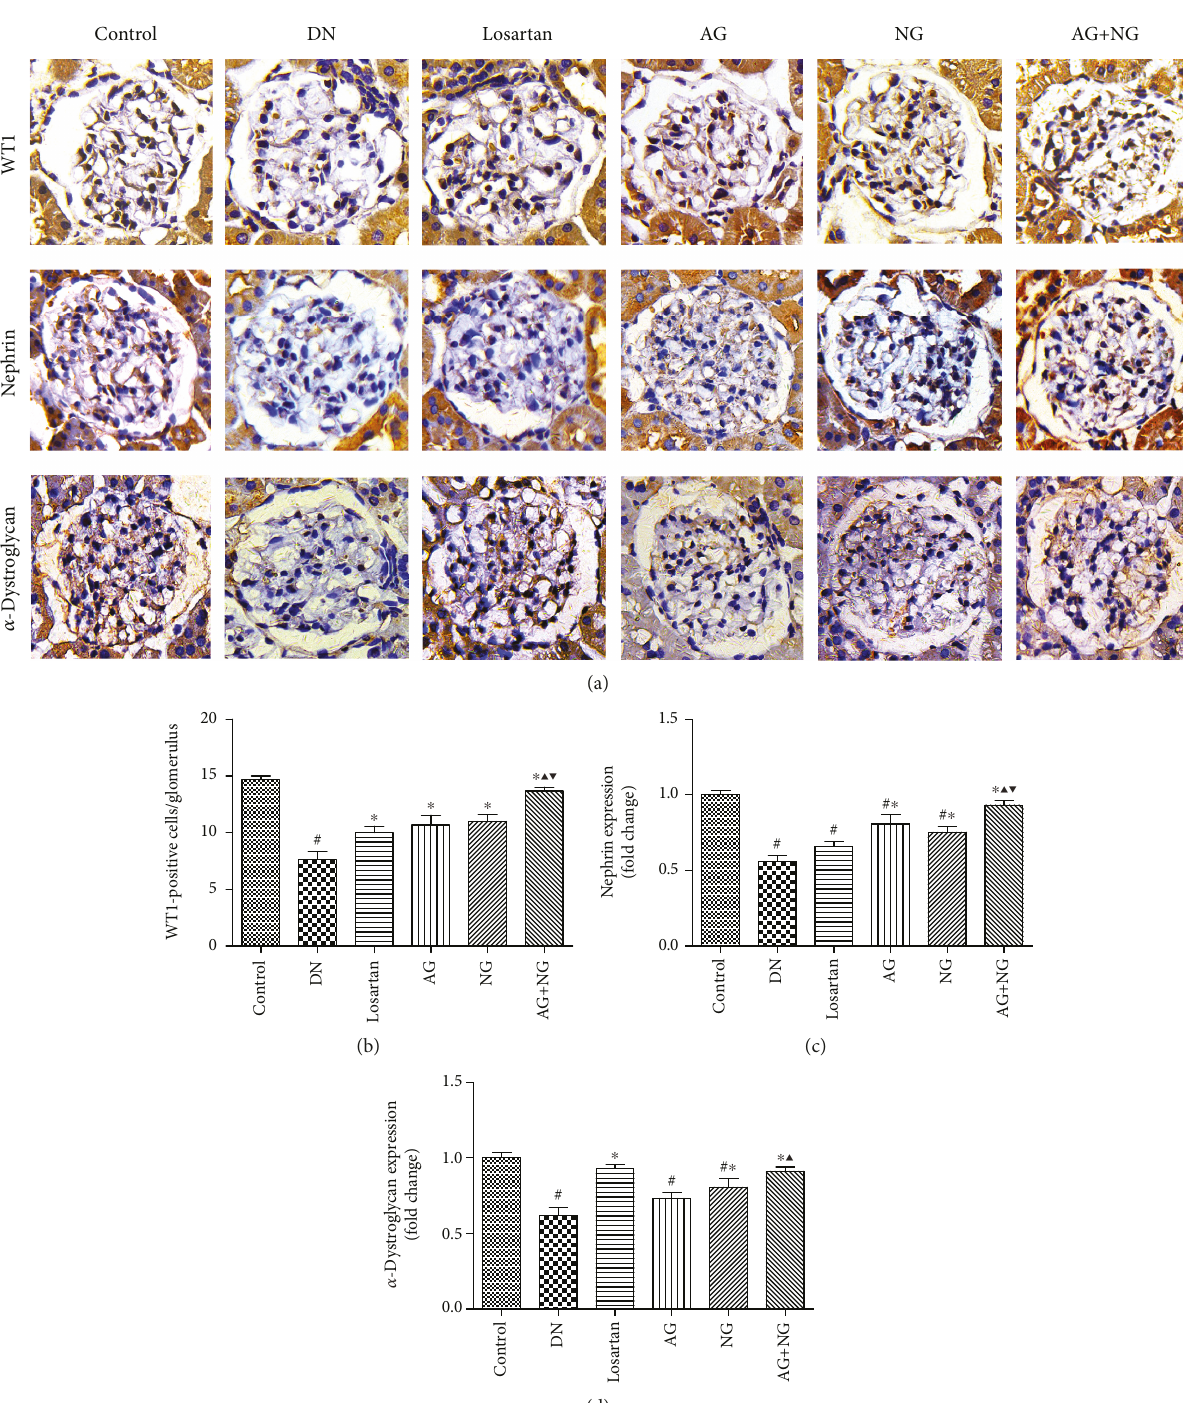
Figure 3: E ff ects of AG and NG on the expression of WT1, nephrin, and α -dystroglycan detected by immunohistochemical staining. Representative photomicrographs of immunostaining for WT1, nephrin, and α -dystroglycan (a) in the glomeruli of kidney sections. Quantitative analyses of changes in the number of podocytes per glomerular volume (b). The number of podocytes per glomerulus was determined by counting the number of WT1-expressing nuclei per glomerulus. Semiquantitative analyses of immunostaining for nephrin (c) and α -dystroglycan (d) per glomerulus. Control: normal control rats; DN: STZ-induced diabetic rats; losartan: DN rats treated with losartan; AG: DN rats treated with Astragalus membranaceus; NG: DN rats treated with Panax notoginseng; AG+NG: DN rats treated with Astragalus membranaceus plus Panax notoginseng. Results were expressed as the mean ± SD . # P < 0 05 vs. control group, ∗ P < 0 05 vs. DN group, ▲ P < 0 05 vs. AG group, ▼ P < 0 05 vs. NG